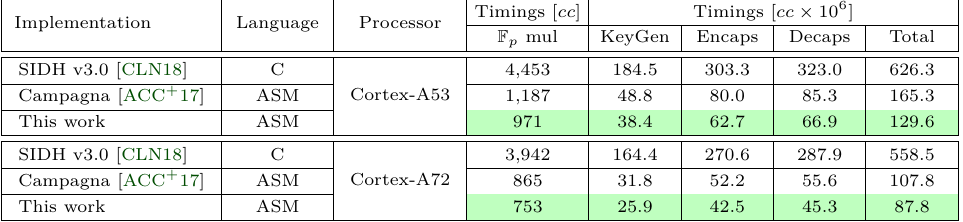
Table 7: Comparison of implementations of the SIKEp503 protocol on ARMv8-A based processors. Timings are reported in terms of clock